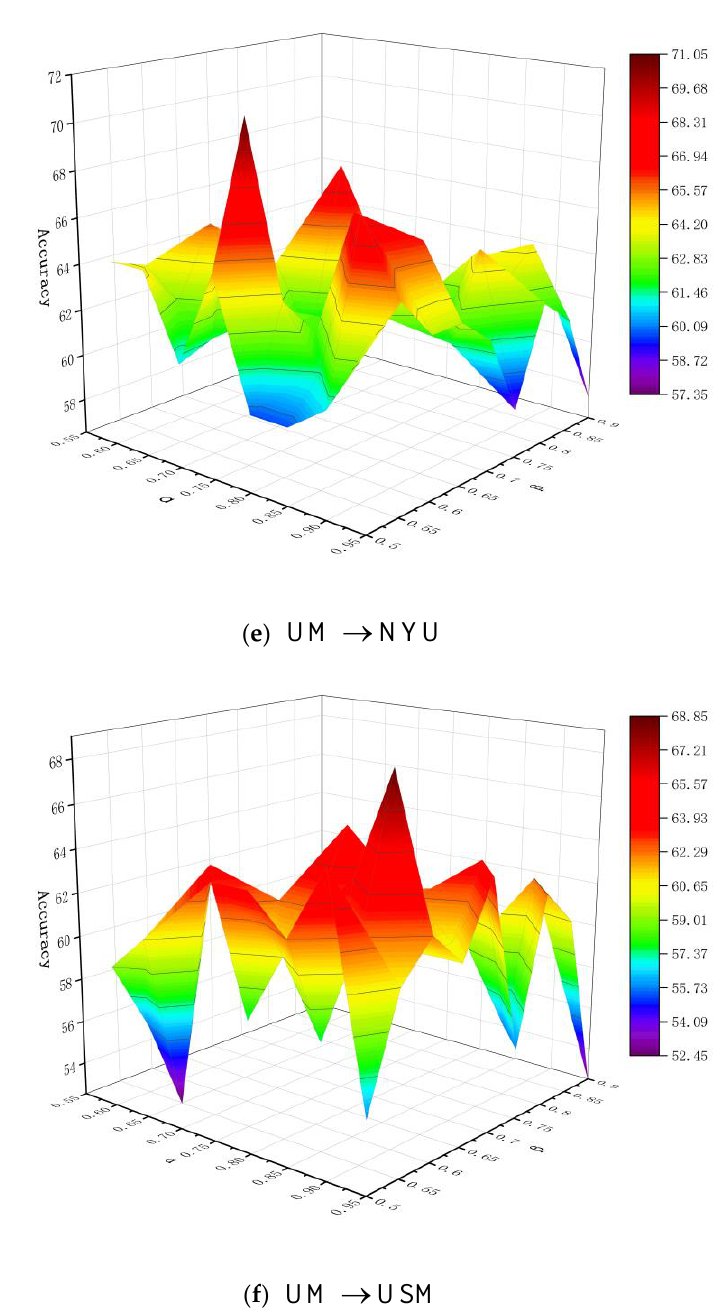
Figure 2. Classification accuracies with respect to different parameter values of α and β on six domain pairs ( a ) NYU → UM; ( b ) NYU → USM; ( c ) USM → UM; ( d ) USM → NYU; ( e ) UM → NYU; ( f ) UM →USM .